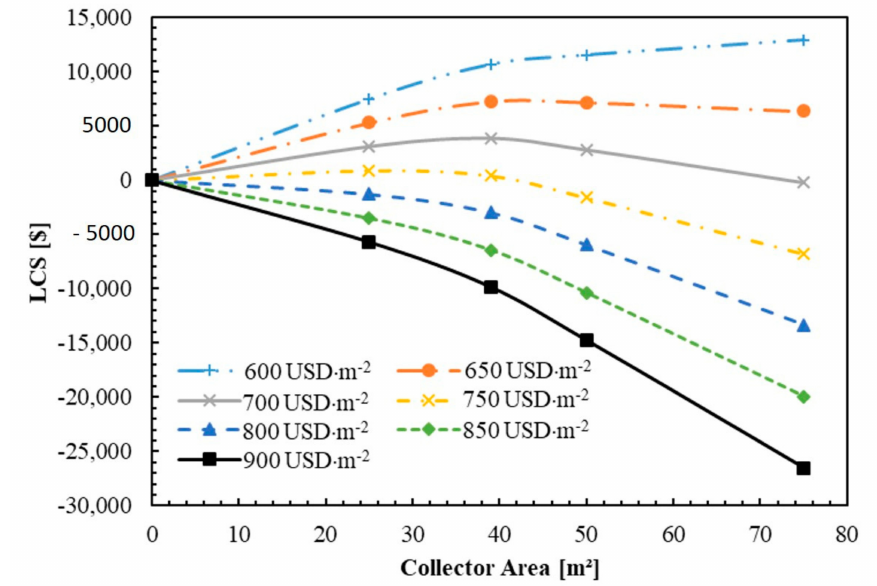
Figure 11. E ff ect of unit cost per m 2 of the solar collector on the life-cycle saving.